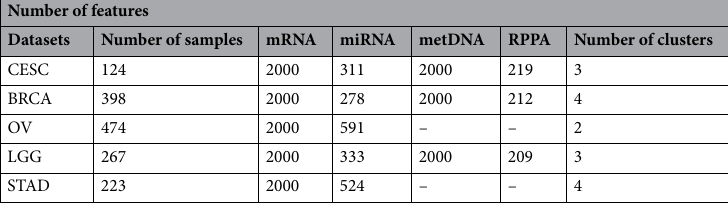
Table 1. Datasets description.